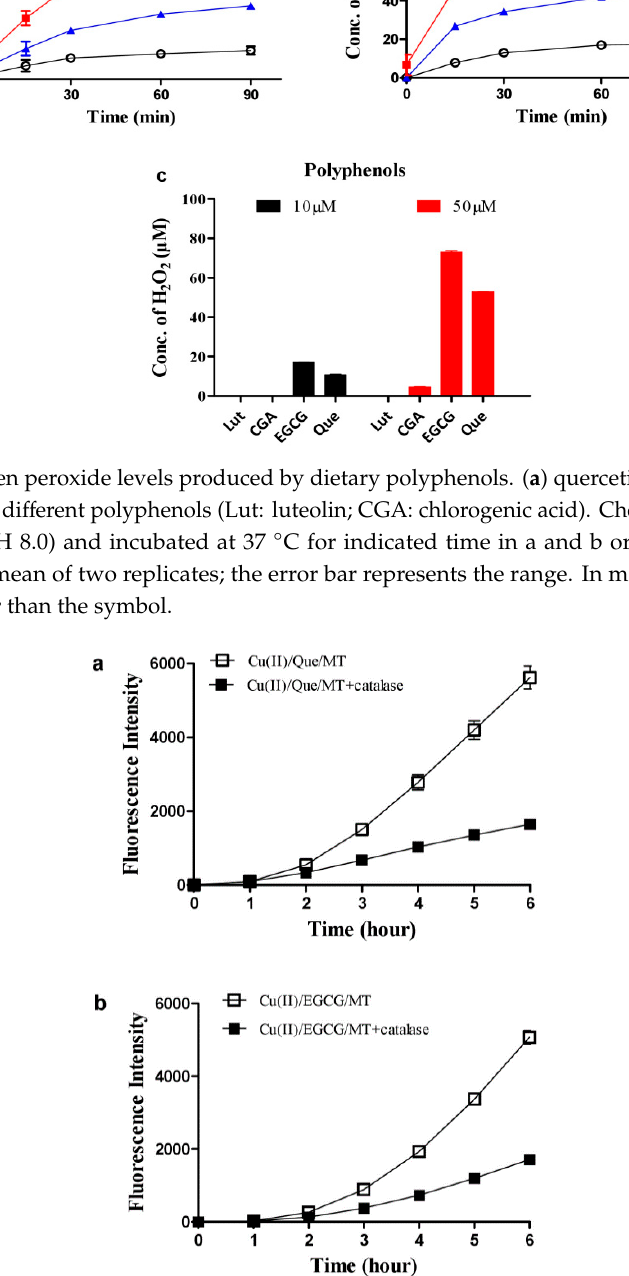
Figure 5. Catalase diminishes melatonin-enhanced ROS production from copper and quercetin or EGCG. ( a ) With quercetin (Que). ( b ) With EGCG. The reaction mixture contained 1 µ M Cu(II), 100 µ M melatonin (MT), 10 µ M EGCG or Que in 0.05 M PBS (pH 7.4) and was incubated at 37 ◦ C. Catalase in the reaction mixture was 5 U / mL. Data are presented as the mean of two replicates; the error bar represents the range; otherwise the range was smaller than the symbol.